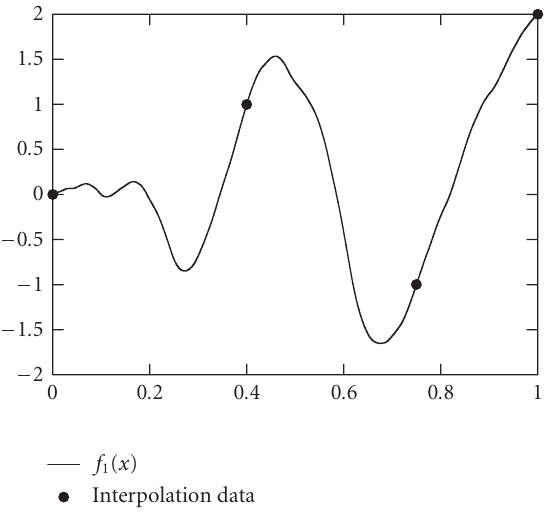
Figure 5.4. E ff ect on spline CHFIF by a change in the hidden variables β n